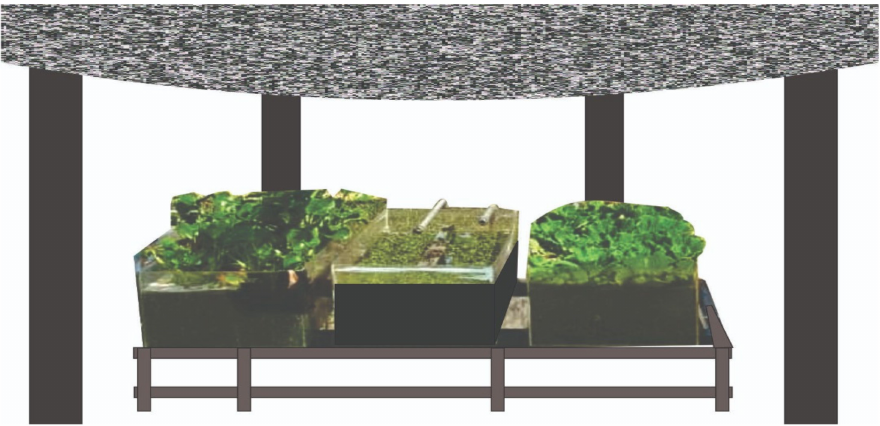
Figure 2. Diagram of the hydroponic cultivation